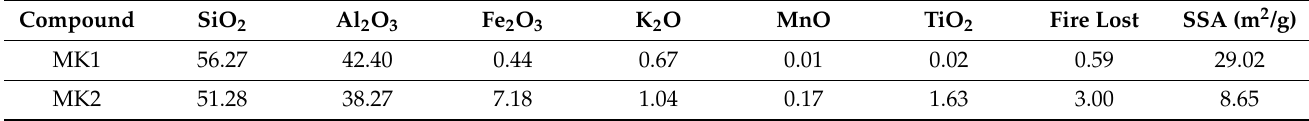
Table 1. Chemical composition MK1 and